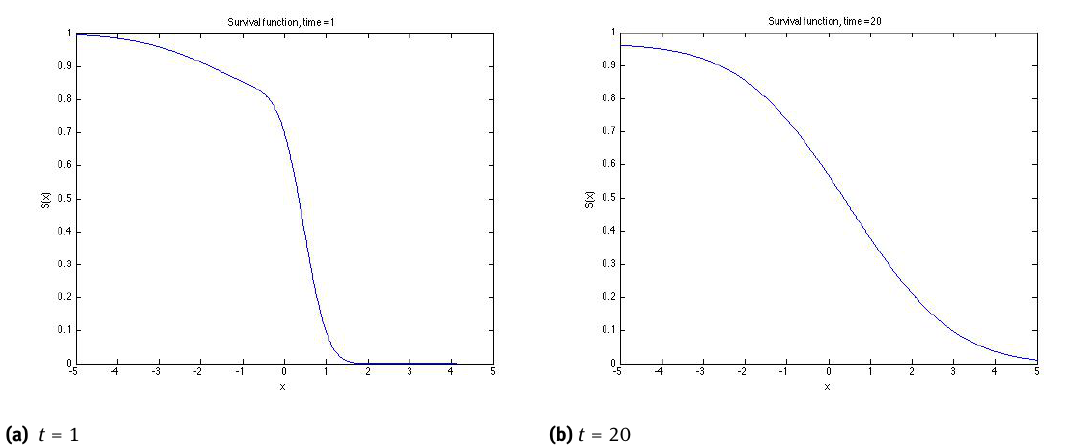
Figure 2: Survival function of B 1 t − B 2 t in the model of Section 2.1 at time t = 1 and t = 20 with parameters h = 0.25 and ρ = 0.9 .